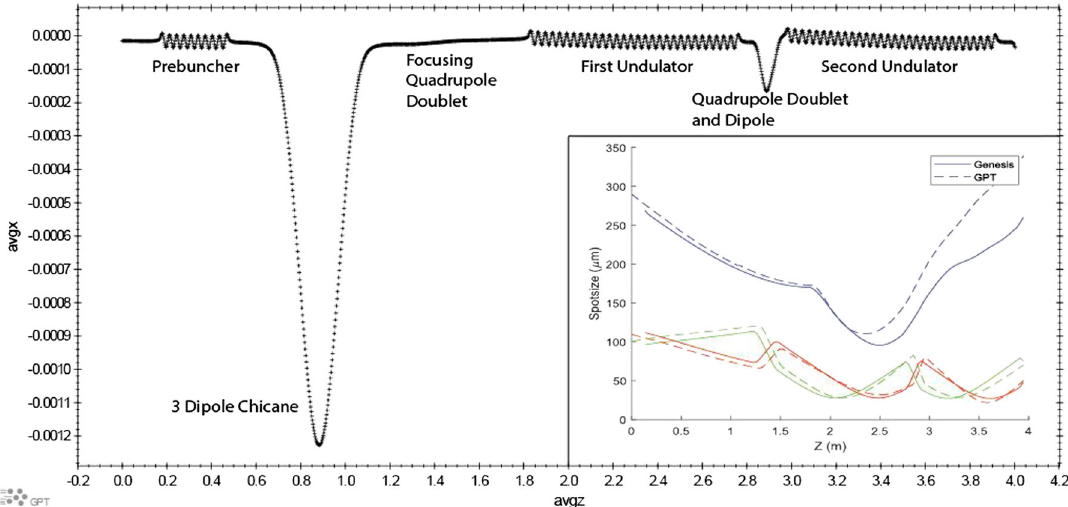
FIG. 8. Trajectory and electron beam and radiation spot size (inset) along the TESSA